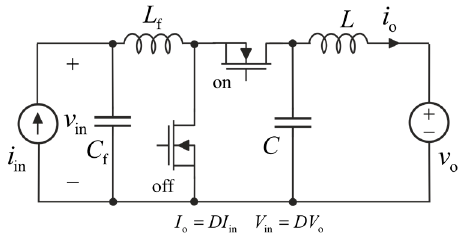
Figure 12. Buck converter as: ( a ) voltage-fed converter; and ( b ) current-fed converter. Energies 2017 , 10 , 1076